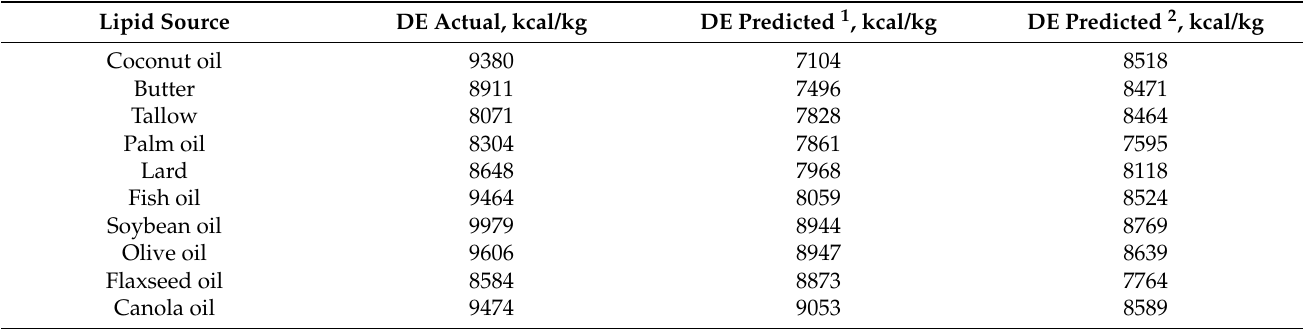
Table 11. Comparison of actual vs. predicted digestible energy (DE) content of fats and oils fed to 19 kg pigs (adapted from